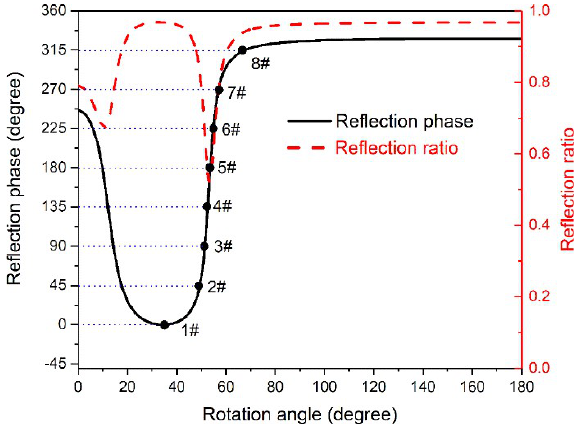
Figure 2. Reflection phase and ratio of the microunit versus rotation angle θ of the inner cavity at 2000 Hz. The black dots denote the specific θ values of eight microunits to fulfill the desired discrete phase shifts. The θ values of these eight microunits are optimised to be 34, 49, 52, 53, 54, 55, 57 and 68°, respectively.